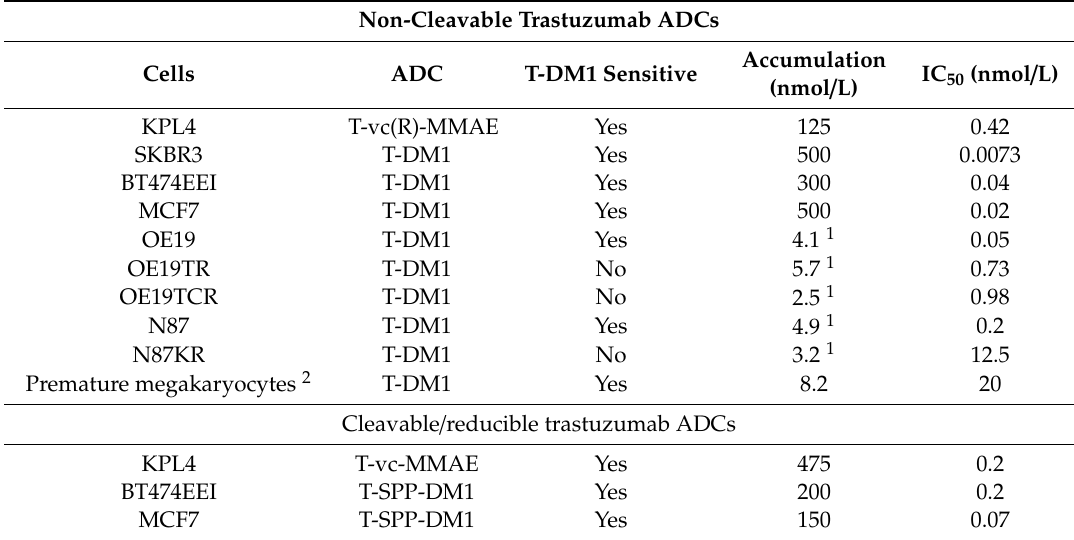
Table 3. Relationship between cell type, and payload accumulation and